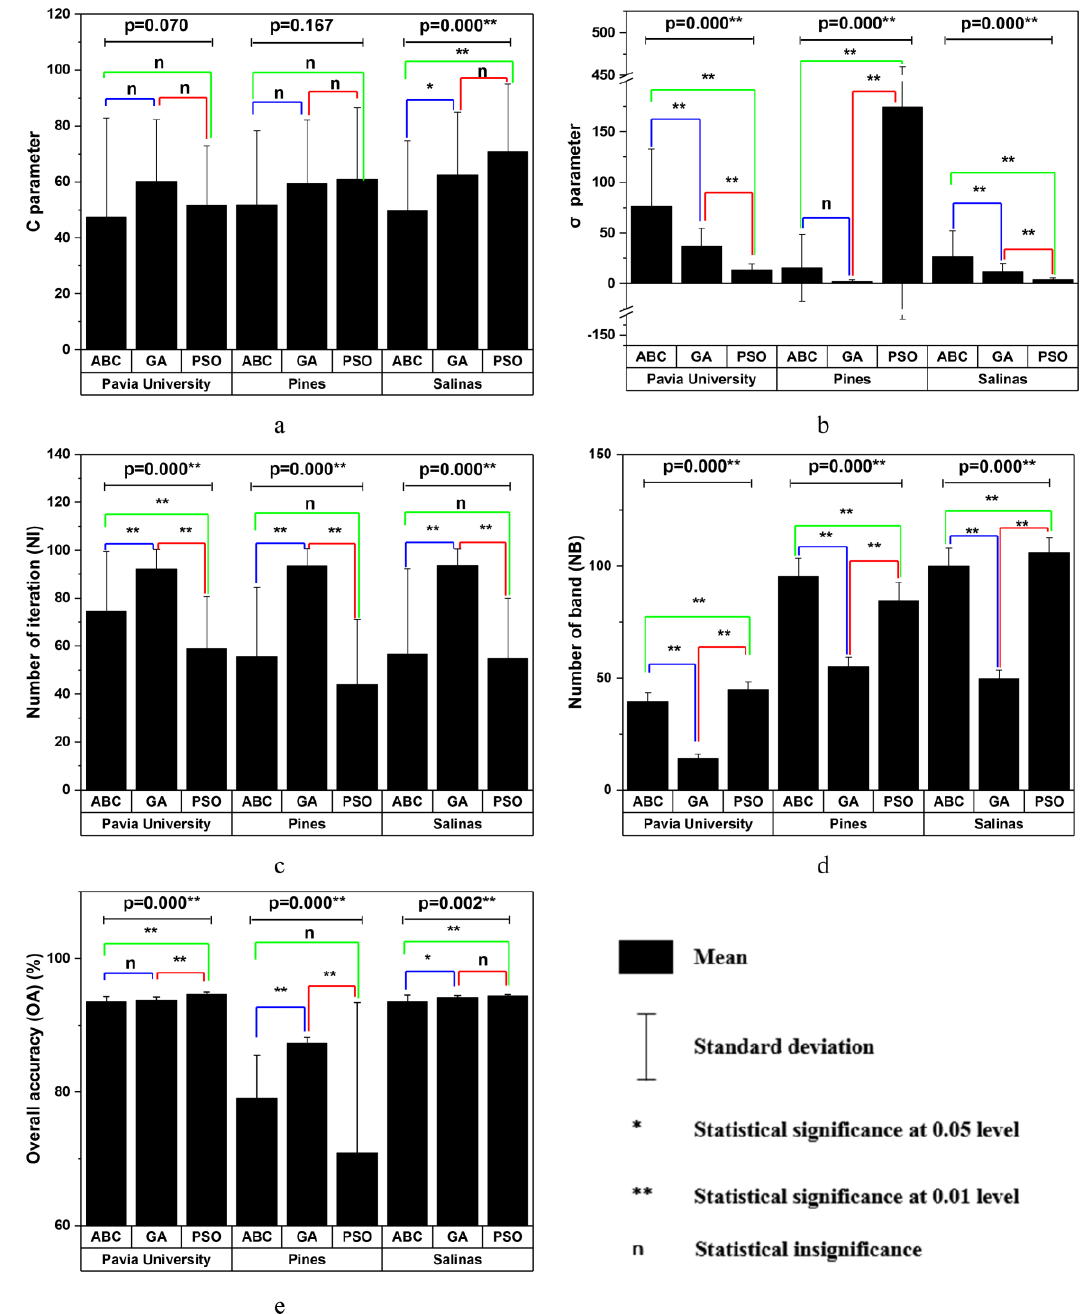
Figure 7. Comparison of three group intelligence (GI) algorithms optimization on the SVM in five aspects: ( a ) C parameter, ( b ) σ parameter, ( c ) number of iteration, ( d ) number of band and ( e ) overall accuracy.